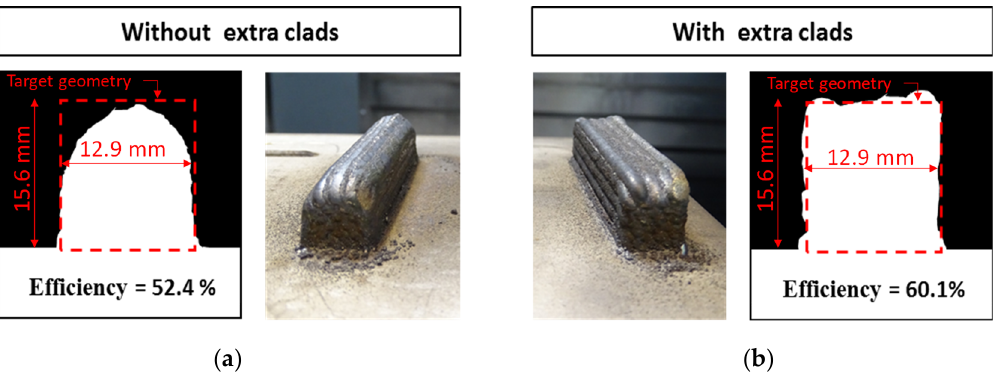
Figure 8. Straight wall results: ( a ) Cross-section without extra clad strategy; ( b ) Cross-section with extra clad strategy. The results from “Geometrical Model and Strategy in Single and Multilayer Structures Deposited by Powder-fed Directed Energy Deposition”, by Ramiro et al. [24].